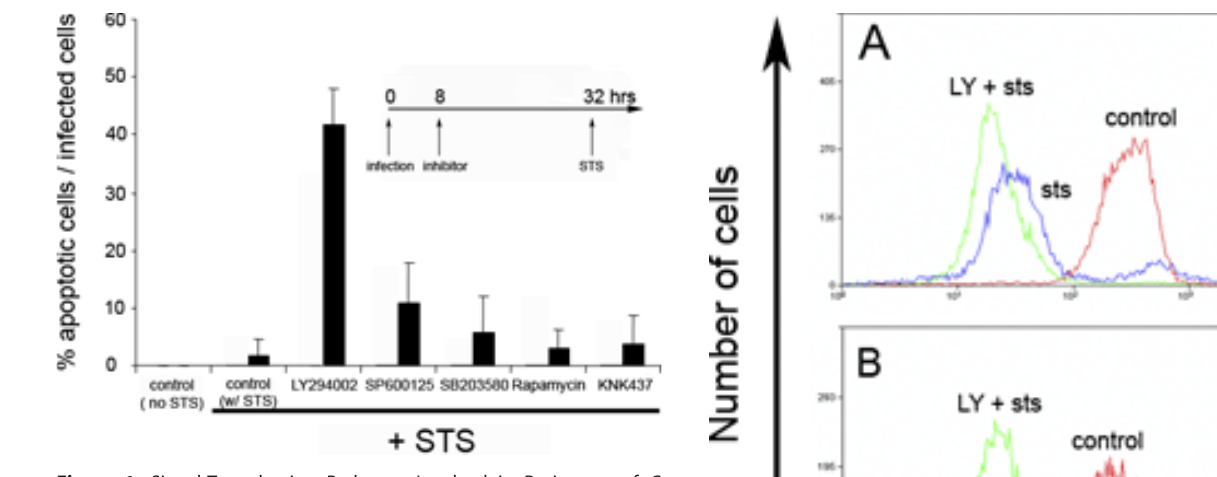
Figure 1. Signal-Transduction Pathways Involved in Resistance of C. trachomatis -Infected Cells against Apoptosis All cells were infected with C. trachomatis at an MOI of 1.0 for 32 h and then treated overnight with 2 l M STS. In uninfected cells that had been treated with STS under the same conditions, 83 6 10% of the cells had apoptotic nuclei. Inhibitors were added 24 h before STS treatment, as indicated in the inset. The inhibitor concentrations (and targeted mediators) were: 50 l M LY294002 (PI3K), 10 l M SB203580 (P38), 10